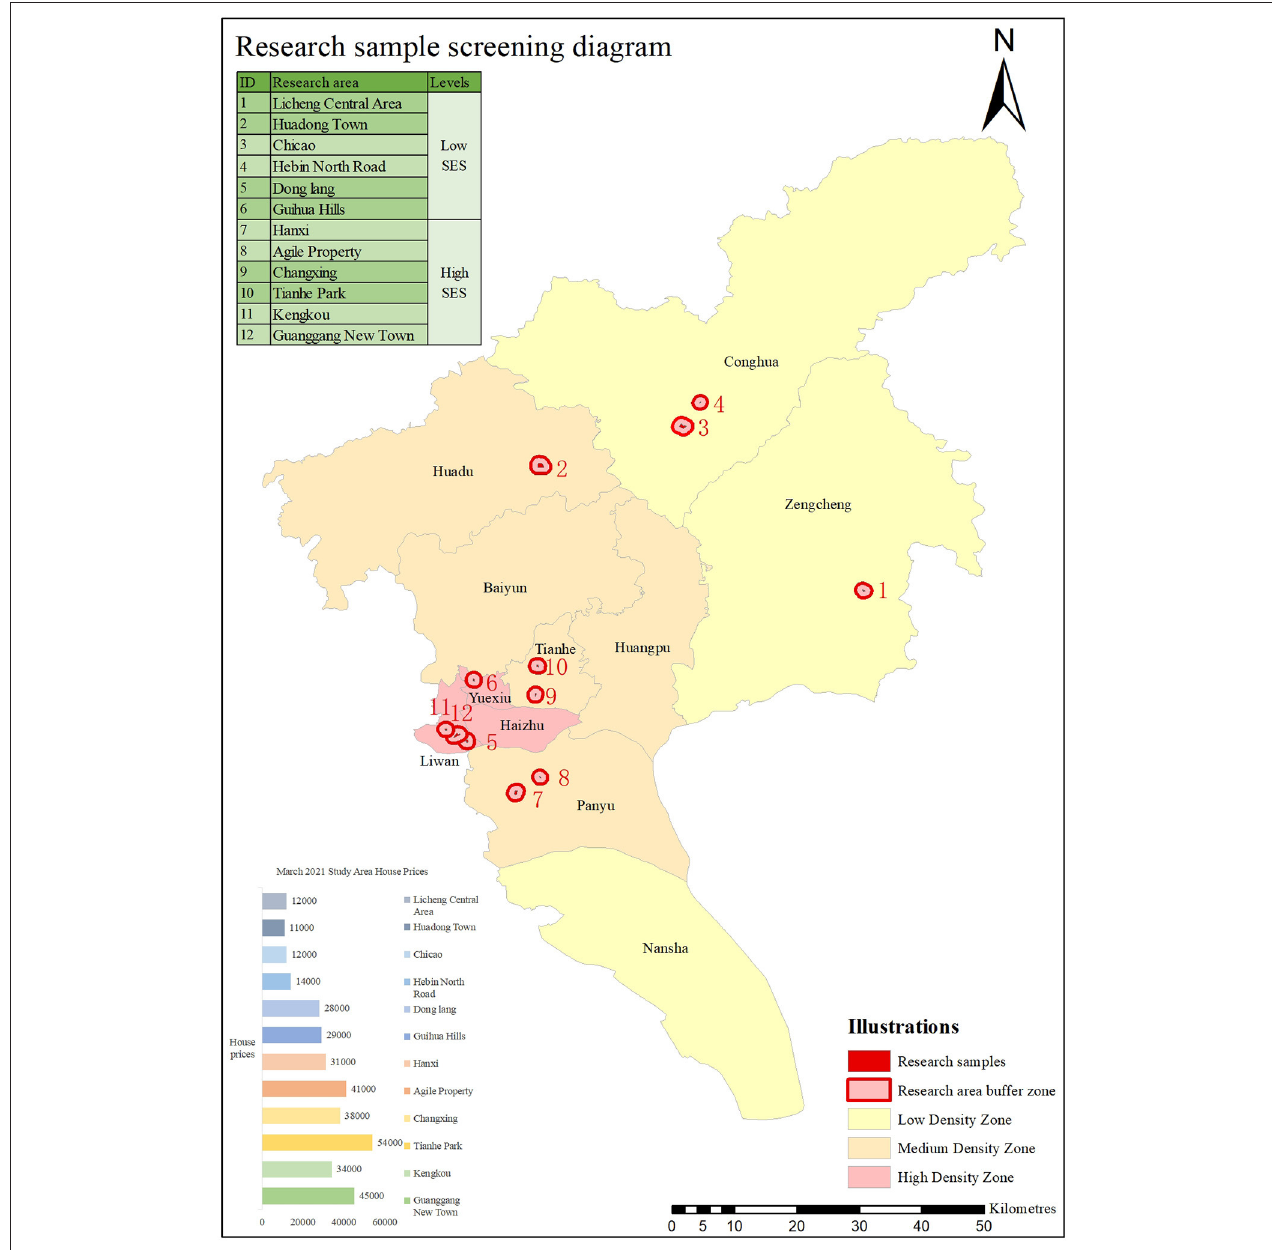
FIGURE 1 | Research sample screening